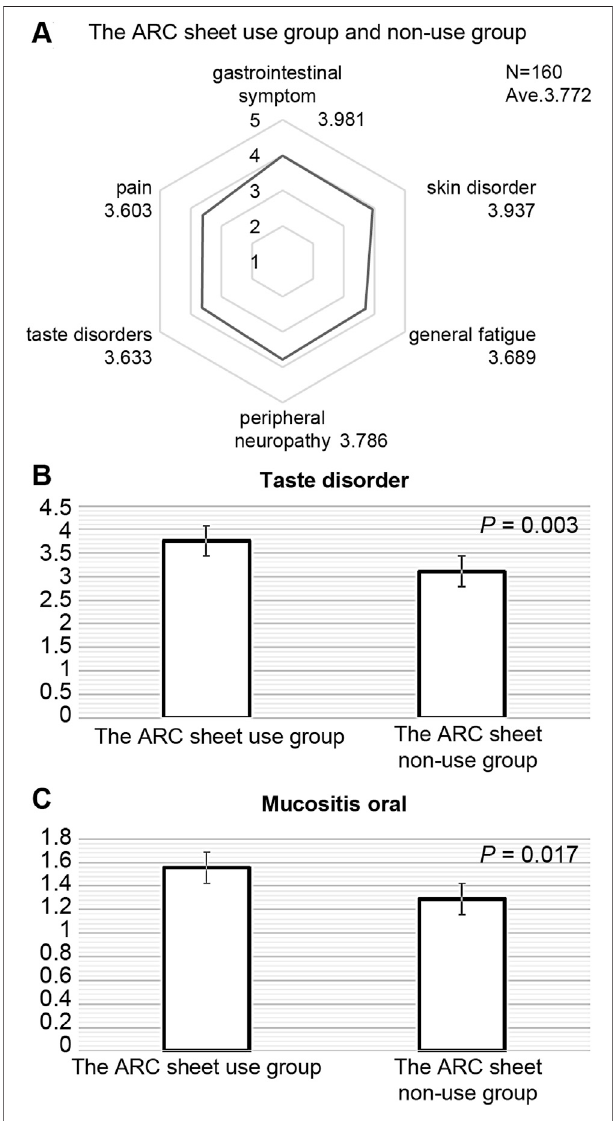
FIGURE 1 | (A) : Adverse events in which patients in the ARC sheet use group and non-use group answered that the adverse events they wanted to communicate to medical staff were well communicated. Gastrointestinal symptoms included symptoms of nausea, decreased appetite, mouth ulcers, diarrhea, and constipation. There is no signi fi cant difference between the ARC sheet use group and the non-ARC sheet use group in terms of symptoms other than stomatitis and taste disorder. (B) : Comparison of satisfaction with the ease of communicating taste disorder adverse events between the ARC sheet use group and the non-use group. The use of the ARC sheet is useful in understanding taste disorder. (C) : Comparison of satisfaction with the ease of communicating adverse events of stomatitis betweentheARCsheet useandnon-use groups.TheuseoftheARCsheetis useful in understanding oral